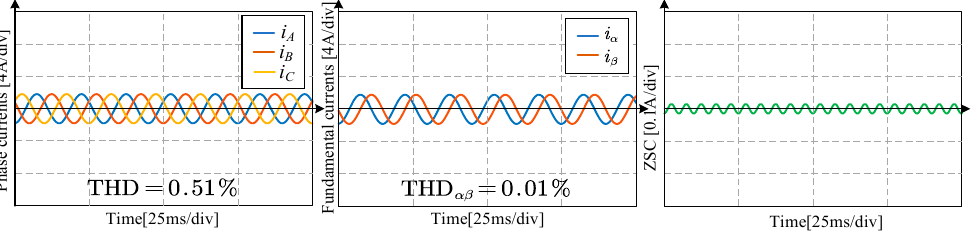
Figure 13. Simulation steady-performance of the conventional controller under 800 rpm reference.